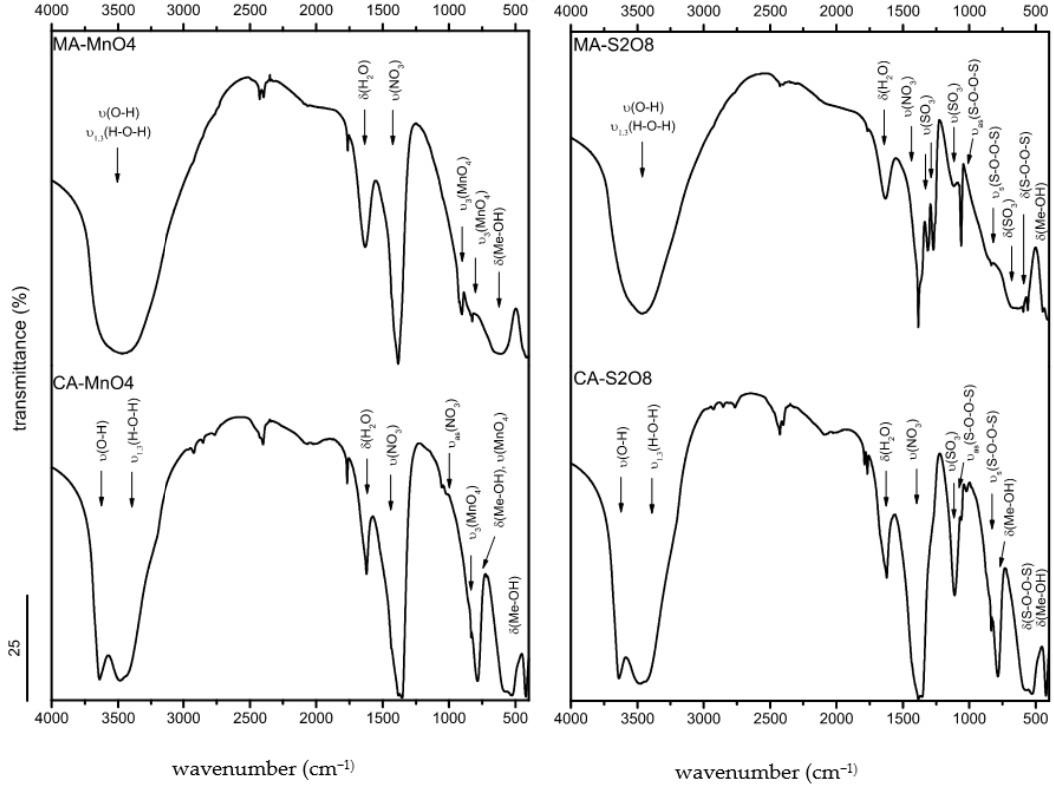
Figure 3. FTIR spectra of the synthesised samples. ( Left panel ) permanganate-ion; ( right panel ) peroxydisulphate-ion. ( Top spectra ) MA samples; ( bottom spectra ) CA samples.